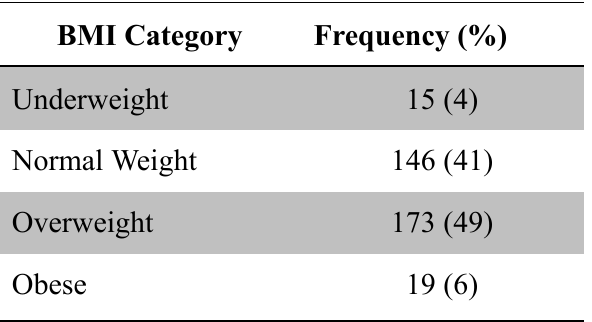
Table 2. Body mass index (BMI) classification